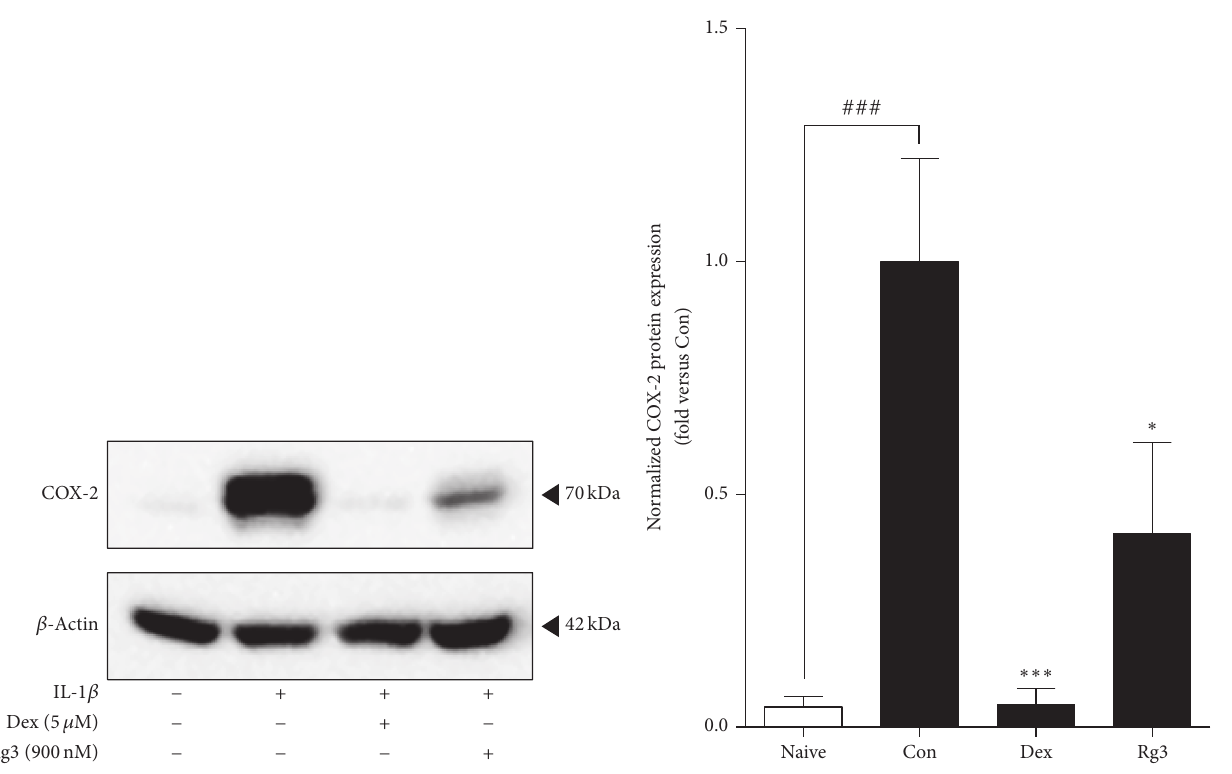
Figure 3: Inhibited IL-1 𝛽 -stimulated COX-2 expression by Rg3 in inflamed A549 cells. (a) The western blot results in representative three separate experiments. (b) COX-2 expression level normalized with 𝛽 -actin was measured by densitometry analysis and represented as bar charts. Statistical significance was determined by unpaired 𝑡 test (one-tail) compared to Con. Values are means ± SEM. ### 𝑃 < 0.001; ∗ 𝑃 < 0.05; ∗∗∗ 𝑃 < 0.001. Naive: normal condition; Con: IL-1 𝛽 treated A549